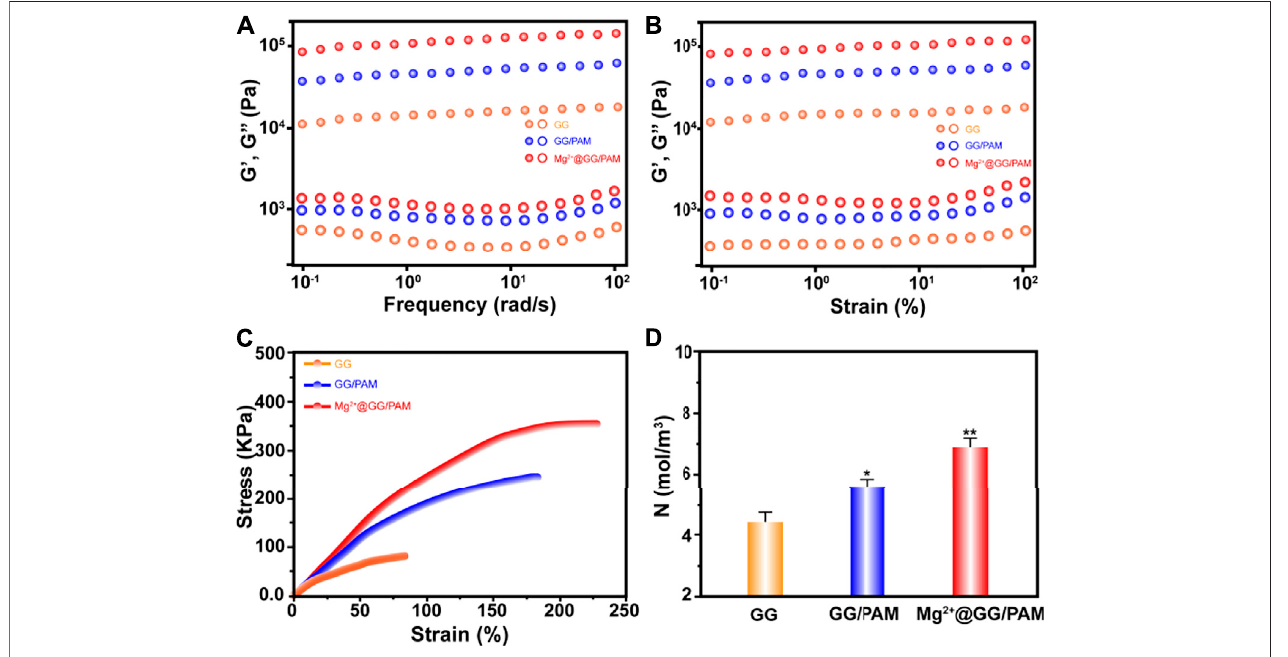
FIGURE2| Frequency dependence (A) andstraindependence (B) ofstorage modulus(G ′ )and lossmodulus(G ″ ),tensilestress – straincurves (C) ,corresponding crosslinking density N as a function of Mg 2+ @GG/PAM hydrogels (D) . The values are represented as mean ± SD ( n (cid:1) 3). * p < 0.05, ** p < 0.01 vs control.